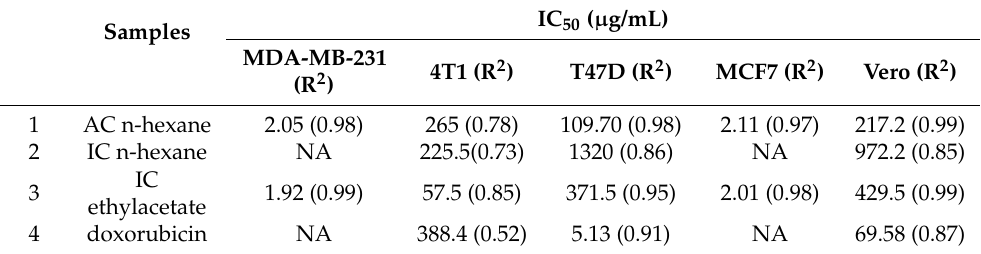
Table 1. The in vitro cytotoxicity assay results of the three partitions against MDA-MB-231, 4T1, T47D, MCF7 and Vero cell growth. IC 50 here describes the concentration of extract that inhibits at least 50% cell